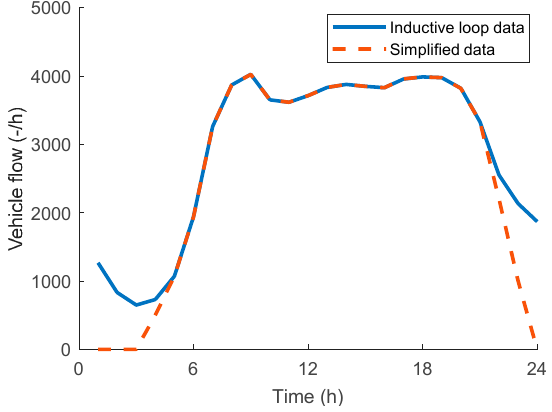
Figure 8. Average daily incoming vehicle flow.